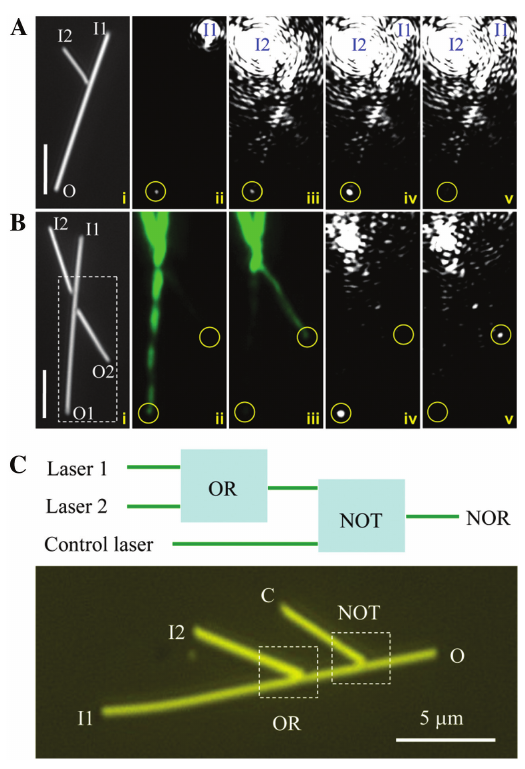
Figure 8: (A) i: Optical image of a silver NW structure with two input terminals (I1 and I2) and one output terminal (O). ii, iii: Scattering images for the case of one input I1 or I2. iv, v: Scattering images